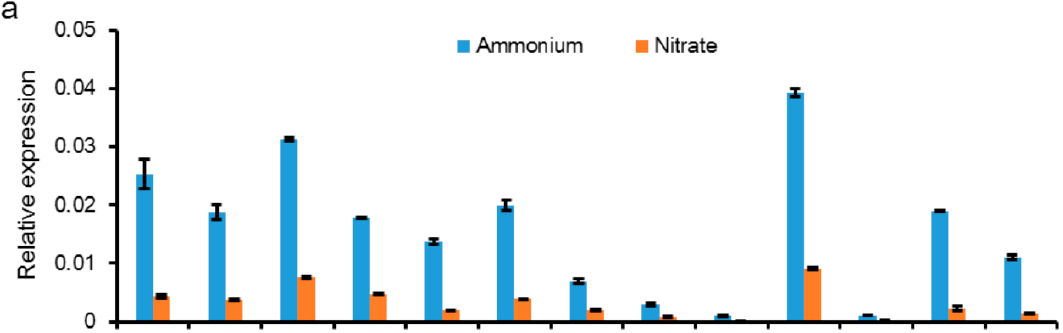
Figure 1. Cont. Figure 1.